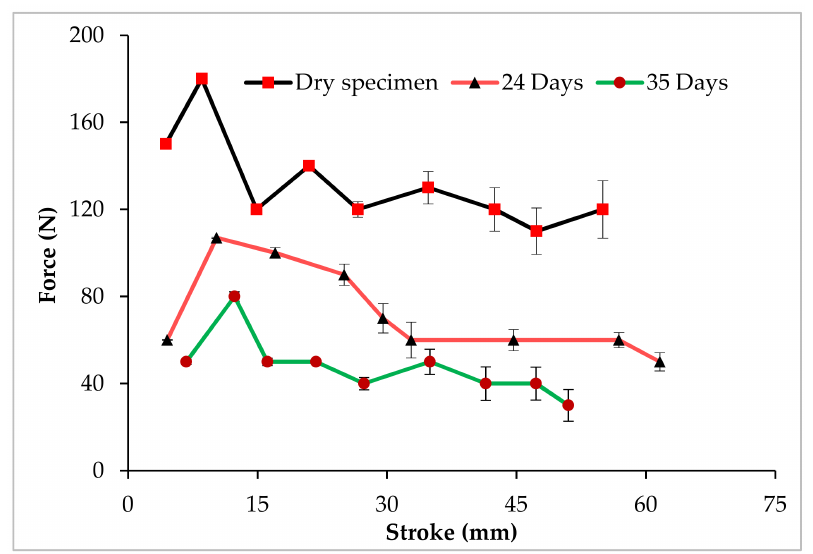
Figure 4. Load versus opening displacement curves of double cantilever beam